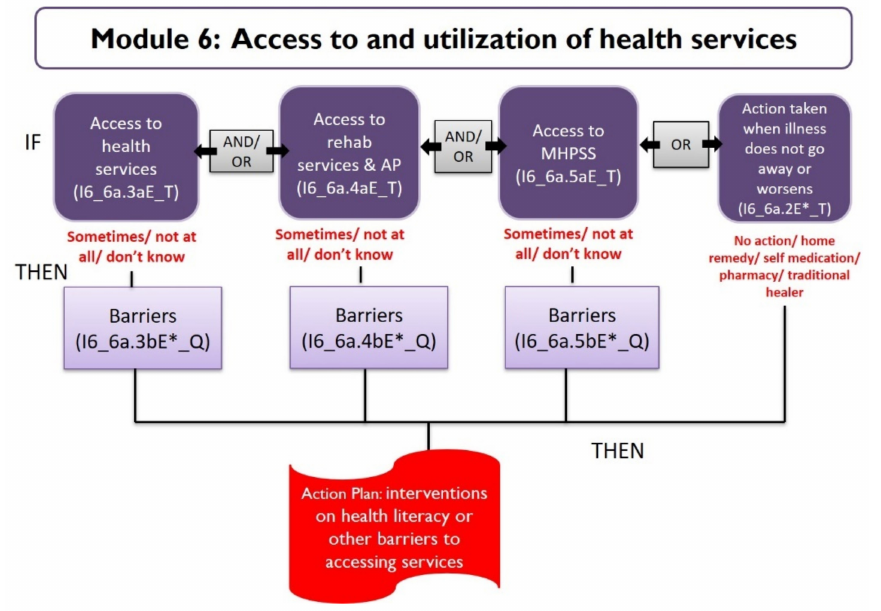
Figure 4. Decision tree for Module